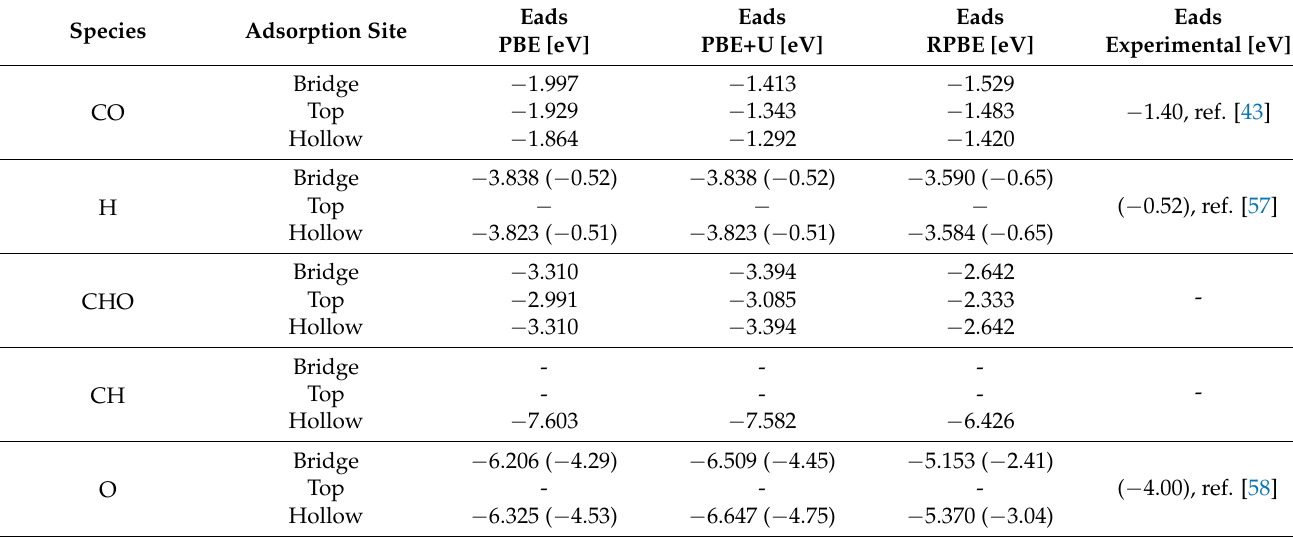
Table 2. Adsorption energies of the investigated species on the three possible adsorption sites (Bridge, Top and Hollow) of Rh (100) slab, calculated with the PBE, PBE+U and RPBE methods. Values within round parenthesis refers to the adsorption energies of the biatomic species, i.e., H 2 and O 2